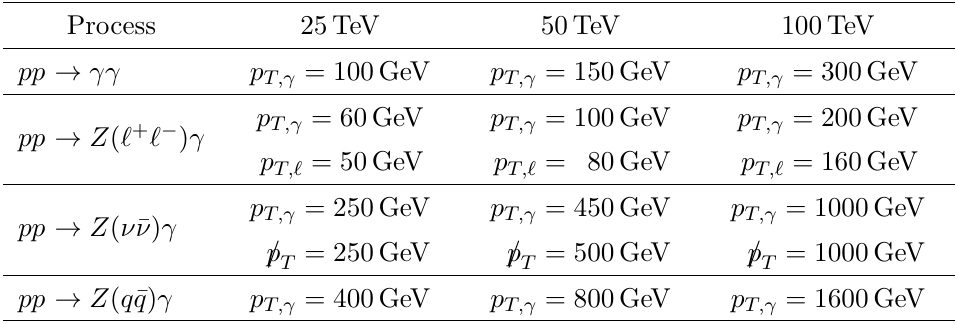
Table 1 . Transverse momentum cuts at higher-energy